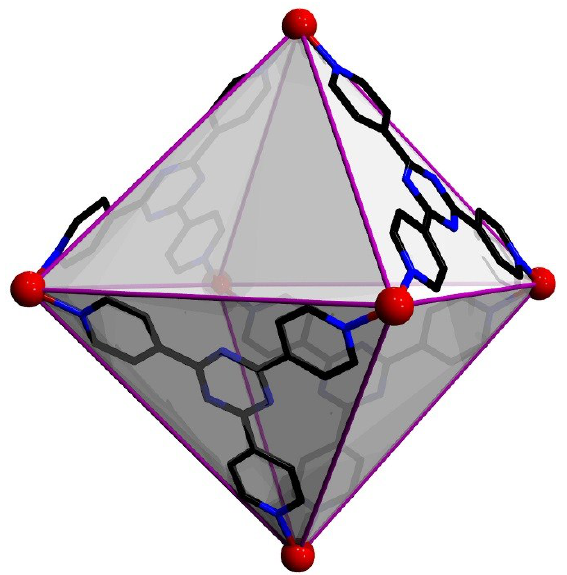
Figure 21. Representation of the M II6 L 4 type cage reported by Fujita et al. Colour code: Pd, red spheres; C, black; N, blue.